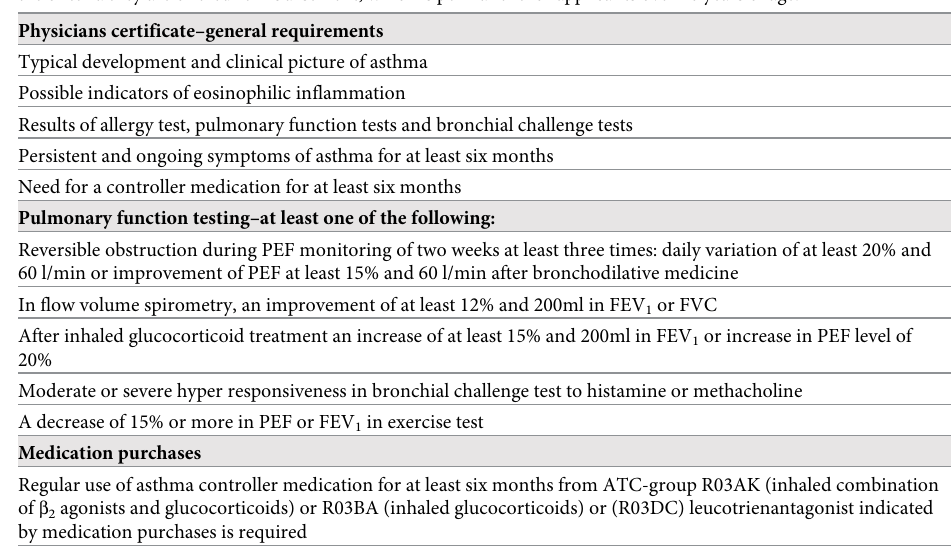
Table 1. The criteria used for the right for justification of reimbursement. For reimbursement, a person has to ful- fil criteria in all three categories: symptoms, pulmonary function testing and medication purchase. Once a person fulfils the criteria they are offered reimbursement, which is permanent for applicants over 16 years of